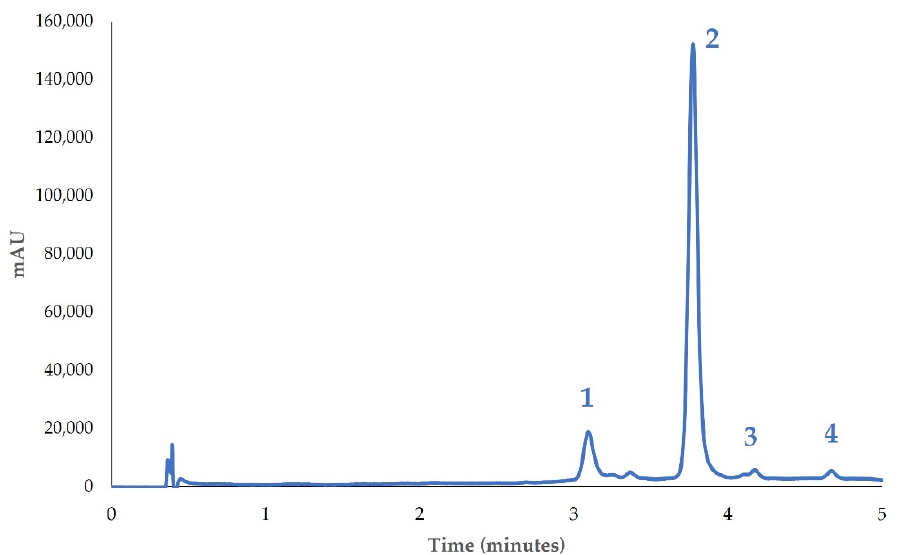
Figure 1. Chromatogram of the anthocyanins in açai extract ( λ = 520 nm). 1. Cyanidin 3- O -glucoside; 2. Cyanidin 3- O- rutinoside; 3. Peonidin 3- O -glucoside; 4. Peonidin 3- O -rutinoside. 2. Cyanidin 3- O -rutinoside; 3. Peonidin 3- O -glucoside; 4. Peonidin 3- O